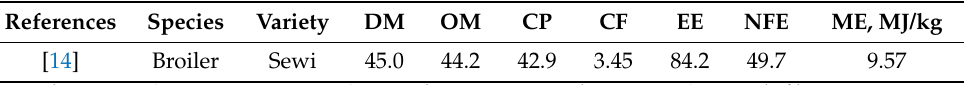
Table 2. Digestion coefficients (%) and metabolizable energy (ME, MJ/kg) of different varieties of date stone meal compared with yellow corn and barley.